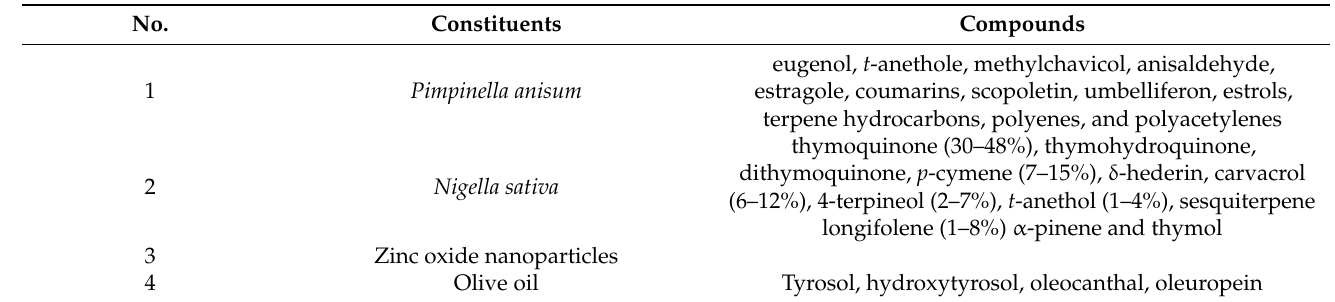
Table 5. Constituent compounds in zinc oxide loaded nanostructure; natural lipid carriers